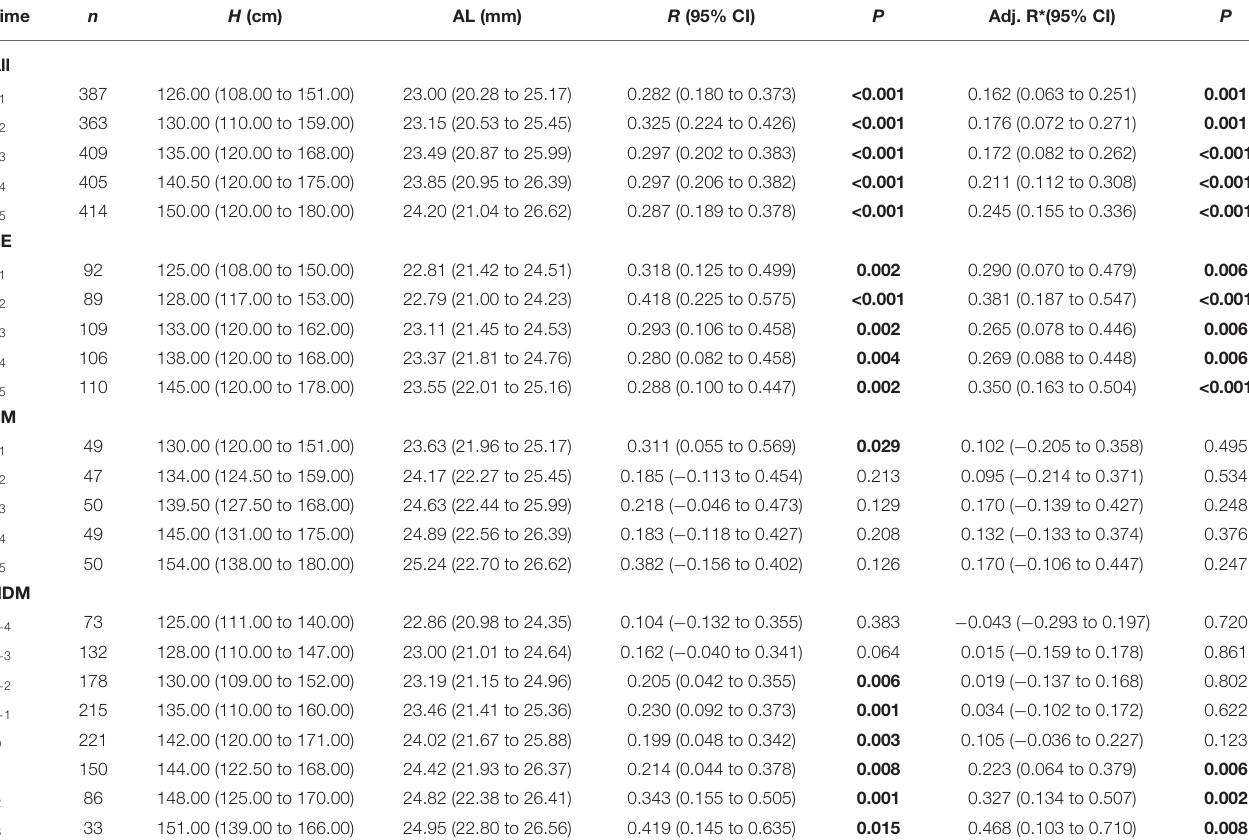
TABLE 3 | Correlation between height and AL in different groups.